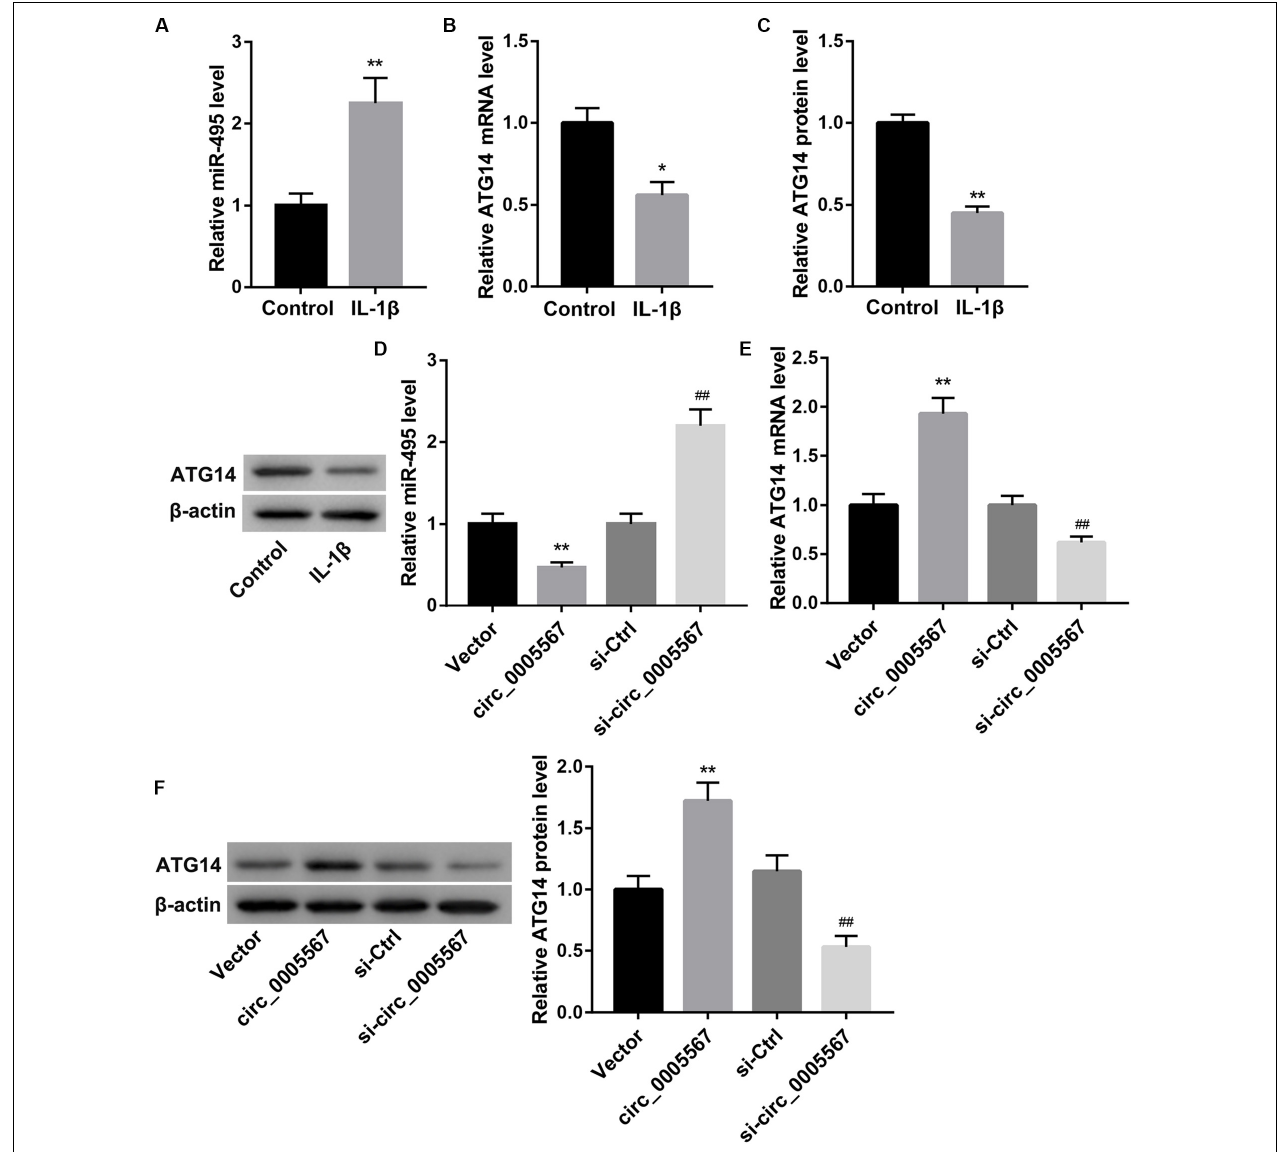
FIGURE 3 | Circ_0005567 negatively regulated miR-495 expression but positively regulated ATG14 expression. (A) MiR-495 expression examined by qRT-PCR analysis, (B) ATG14 mRNA level determined by qRT-PCR analysis, and (C) ATG14 protein level examined by western blot in PBS (control)- or IL-1 β -treated chondrocytes. (D) MiR-495 expression examined by qRT-PCR analysis, (E) ATG14 mRNA level determined by qRT-PCR analysis, and (F) ATG14 protein level examined by western blot in chondrocytes transfected with circ_0005567 overexpression vector, empty vector, si-circ_0005567, or si-Ctrl in the presence of IL-1 β . The data are expressed as mean ± standard deviation from three independent experiments. * P < 0.05, ** P < 0.01, versus the Control or Vector group; ## P < 0.01, versus the si-Ctrl